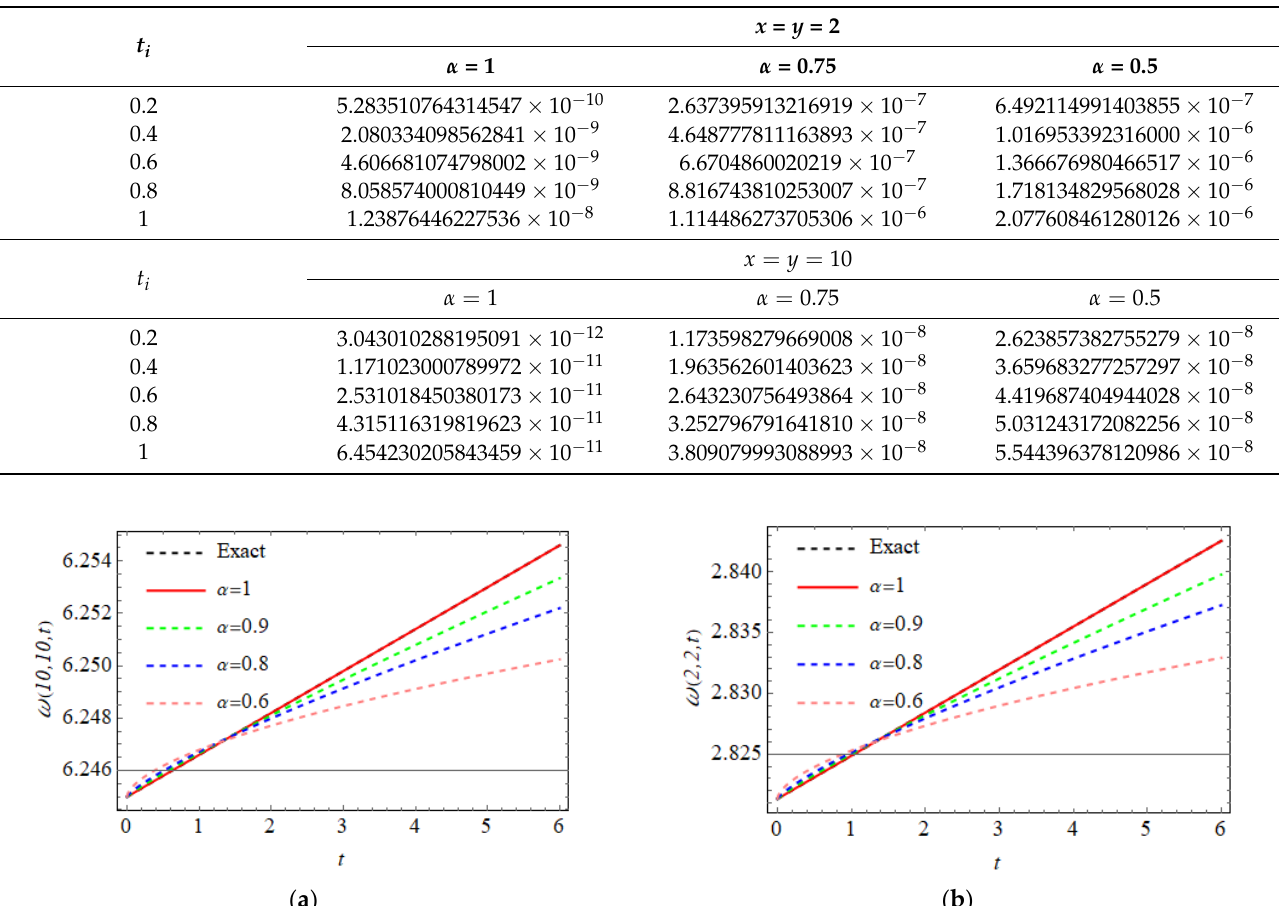
Table 6. Comparison of residual errors of the third analytical approximate FSS of nonlinear time- FGBPM (42) at various values of fractional order α .